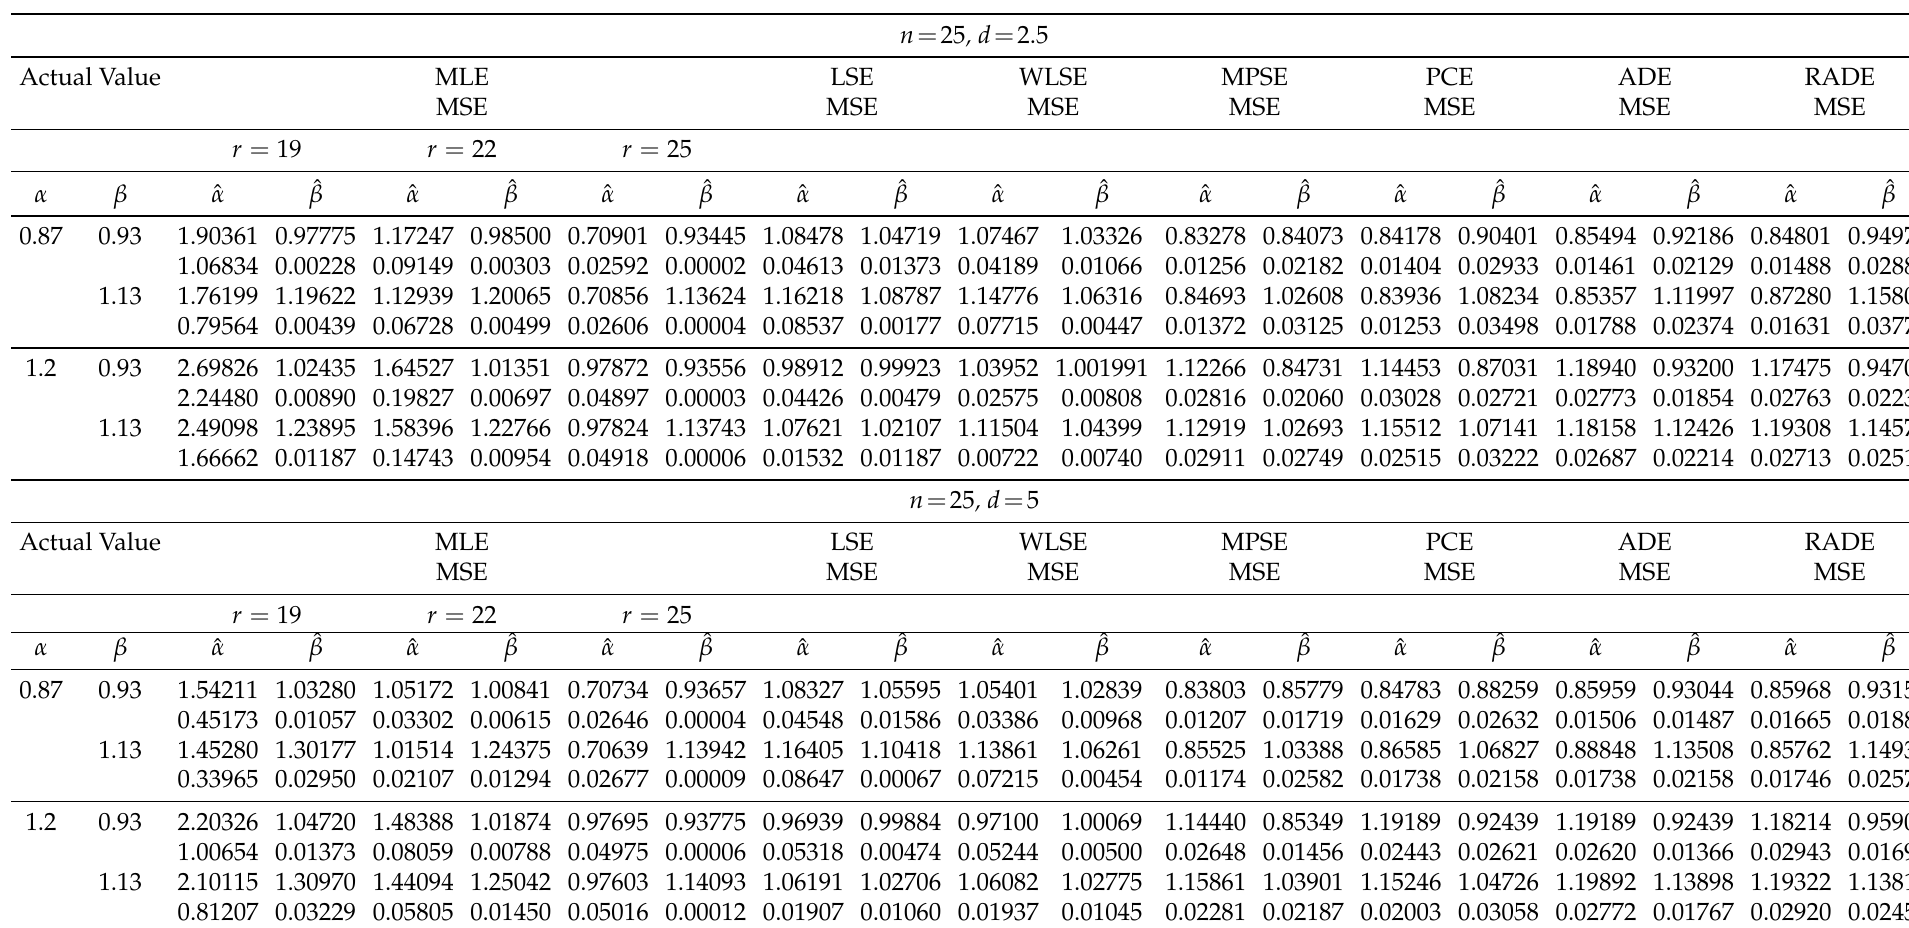
Table 3. The maximum likelihood estimates (MLEs), least square estimates (LSEs), weighted least squares estimates (WLSEs), maximum product of spacing estimates (MPSEs), percentile estimates (PCEs), Anderson–Darling estimates (ADEs), right-tail Anderson–Darling estimates (RADEs), and their mean square errors (MSEs). n = 25 , d =